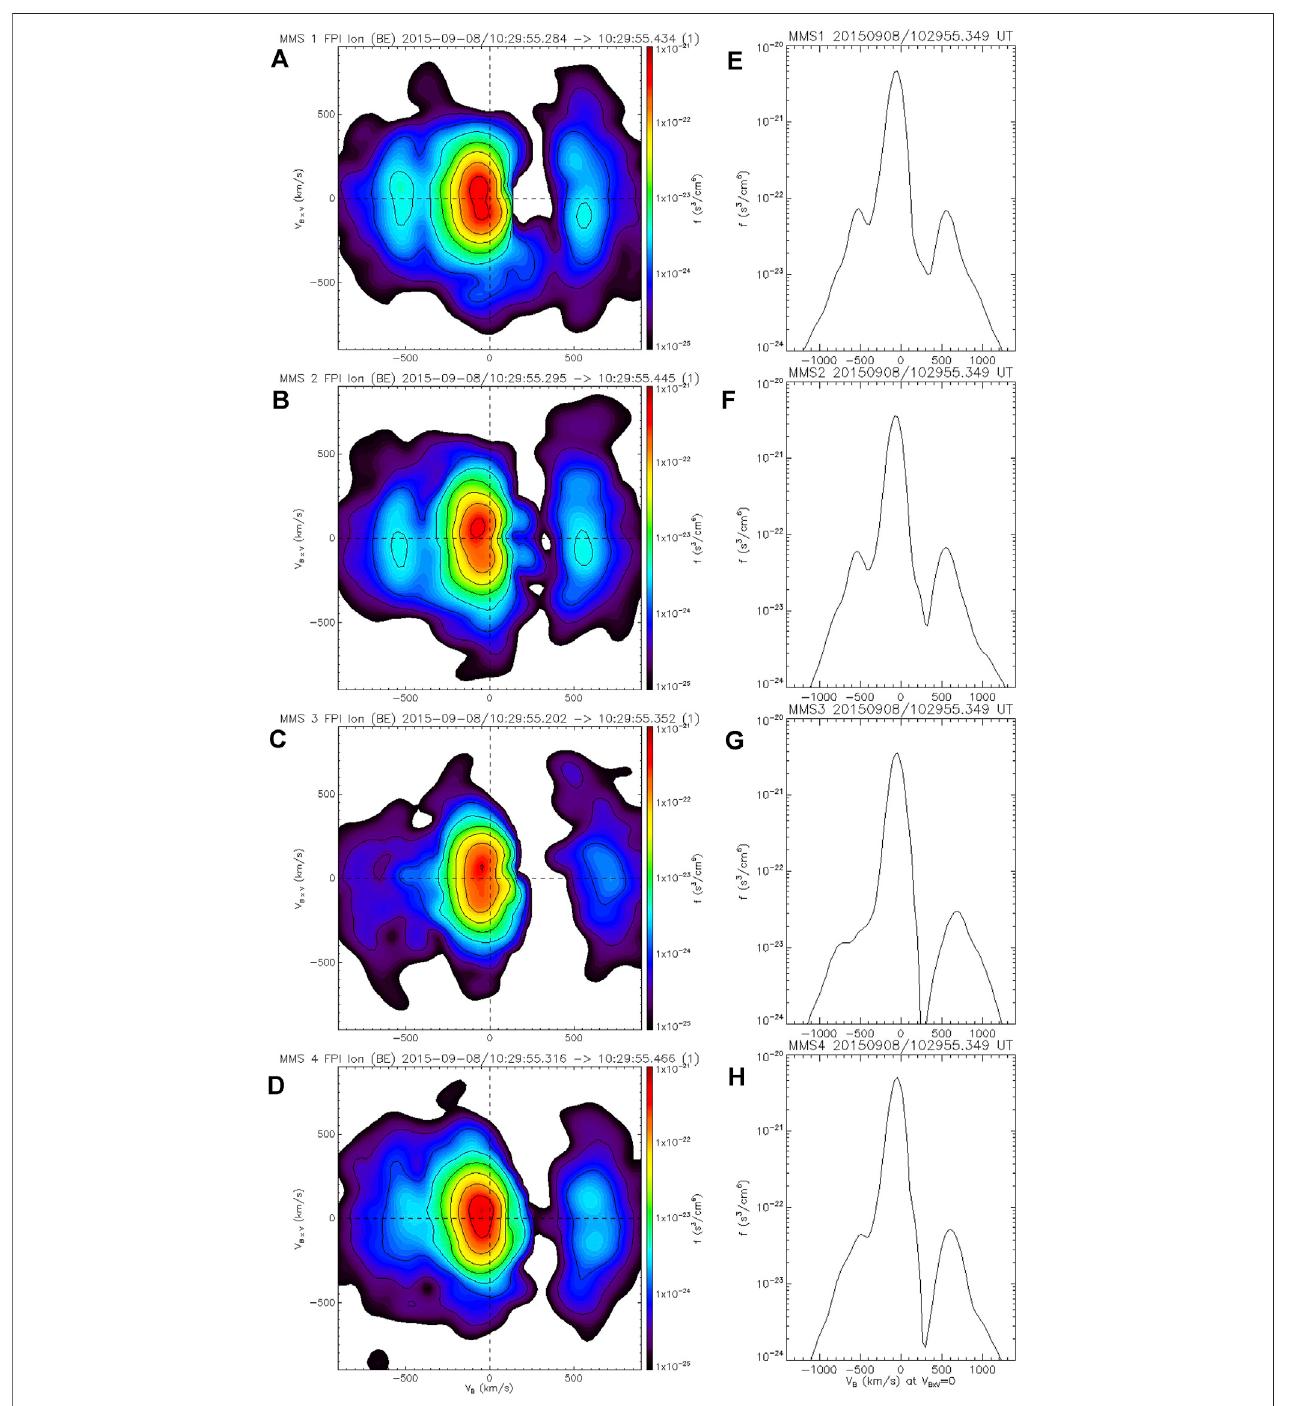
FIGURE 4 | Ion velocity distribution functions at 1029:55.349 UT: (A) 2-D ion phase space density at MMS-1; (B) 2-D ion phase space density at MMS-2; (C) 2-D ion phase space density at MMS-3; (D) 2-D ion phase space density at MMS-4; (E) 1-D cut at MMS-1; (F) 1-D cut at MMS-2; (G) 1-D cut at MMS-3; (H) 1-D cut at